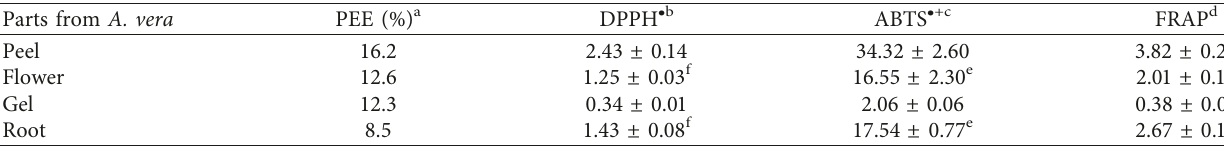
Table 2: Scavenging of the 1,1-diphenyl-2-picrylhydrazyl radical (DPPH • ), 2,2 ′ -azino-bis(3-ethylbenzothiazoline-6-sulphonic acid) (ABTS _ + ), ferric-reducing antioxidant power (FRAP), and extraction yield of four plant parts of A. vera . Parts from A.